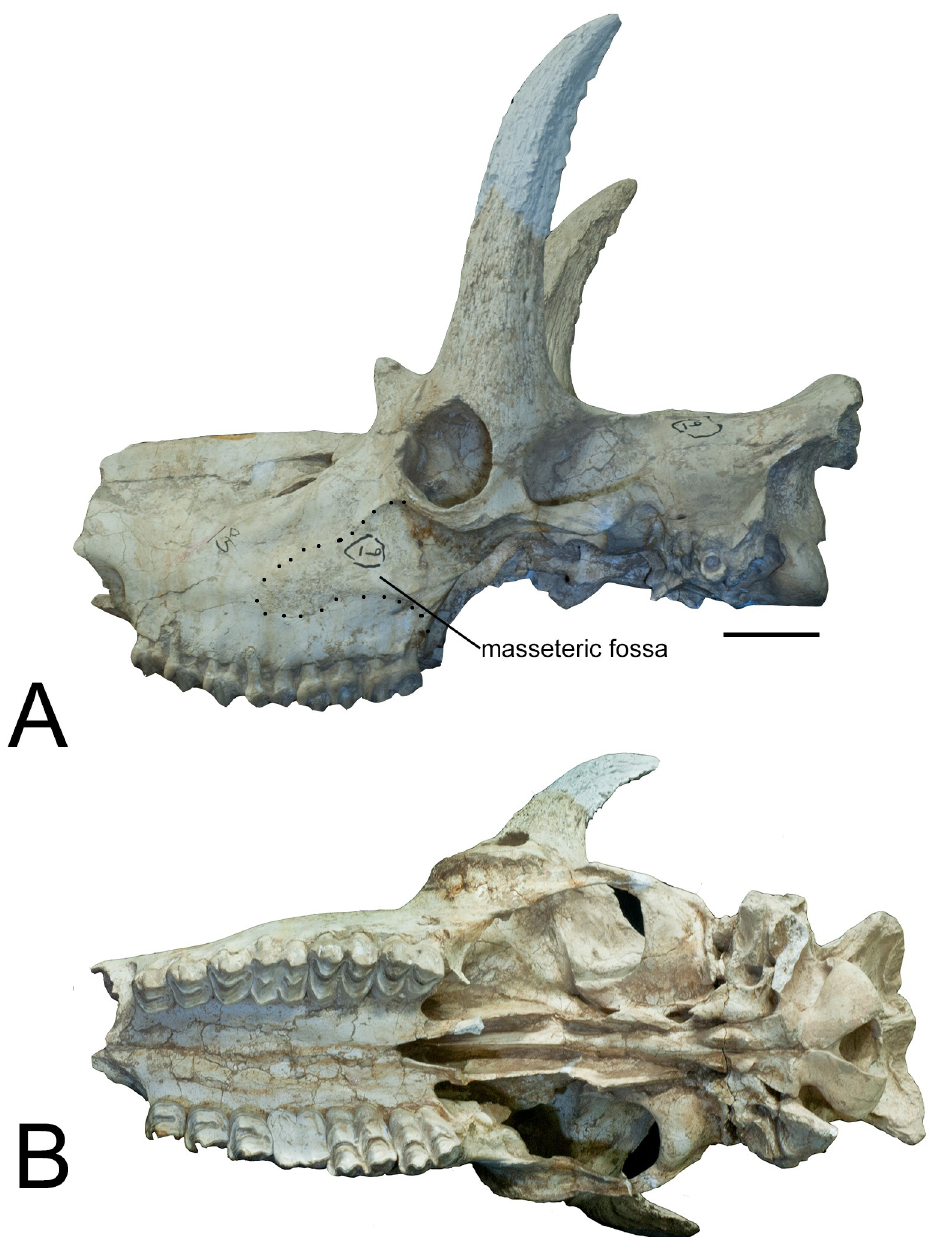
Fig 2. Schansitherium tafeli skull HMV 0945. (A) Left lateral aspect. (B) Ventral view. Scale 50mm. the cranial articular facet from the dorsal lamina. The caudal portion of the dorsal lamina is notched between the caudal articular processes. The articular facet is semilunar in shape from dorsal view. The cranial articular process is elongated but flattened. In lateral view, the trans- verse process presents as a raised, thin, elongated ridge that extends between the openings of the transverse foramen towards the caudal vertebral body (Fig 11A). There is no distinct dorsal tubercle visible (Fig 11A). The caudal opening of the transverse foramen is at the middle of the